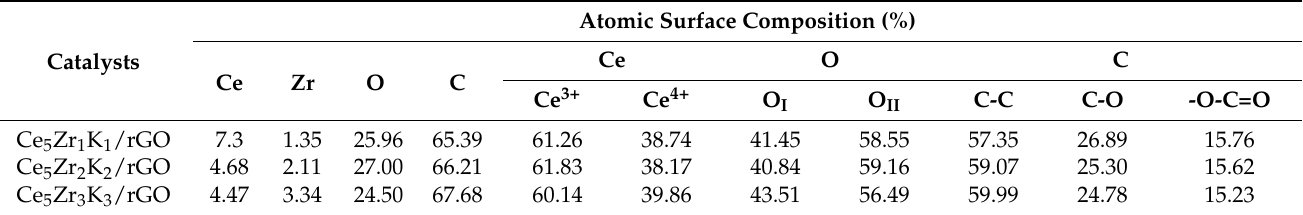
Figure 8. X-ray photoelectron spectroscopy (XPS) spectra for ( a ) Ce 3d, ( b ) Zr 3d, ( c ) O 1s and ( d ) C 1s of the CeZrK/rGO catalysts. Table 2. Atomic surface composition of CeZrK/rGO catalysts determined from XPS.